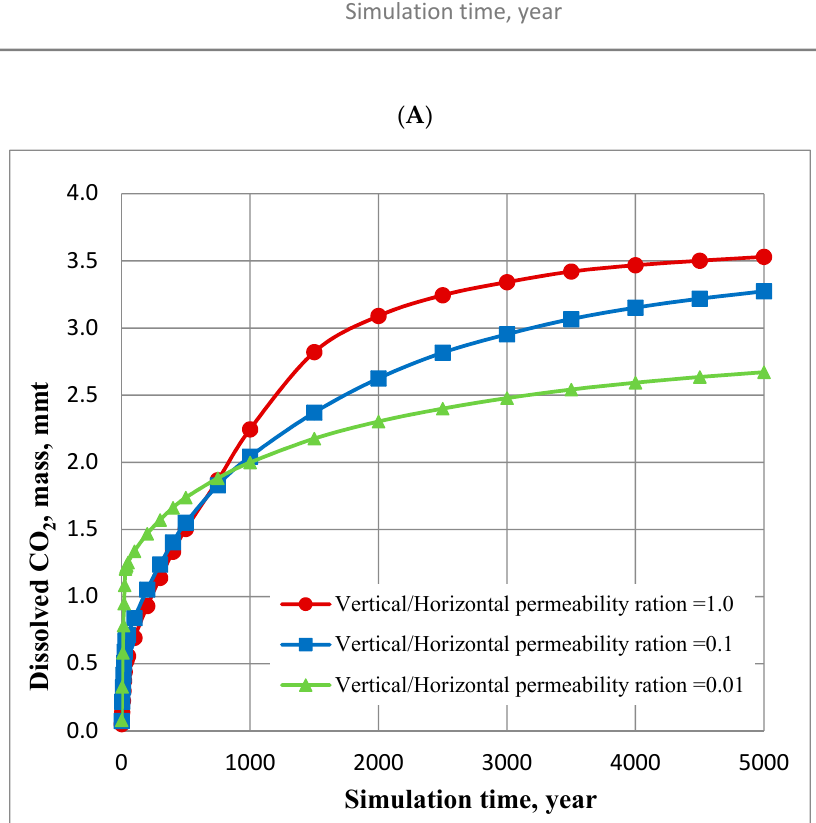
Figure 11. ( A ). Impact of vertical-to-horizontal permeability ratio on the integrated free CO 2 for cases 8, 9 and 10. ( B ). Impact of vertical-to-horizontal permeability ratio on dissolved CO 2 gas in a homogeneous domain for cases 8, 9 and 10 in Table 3.